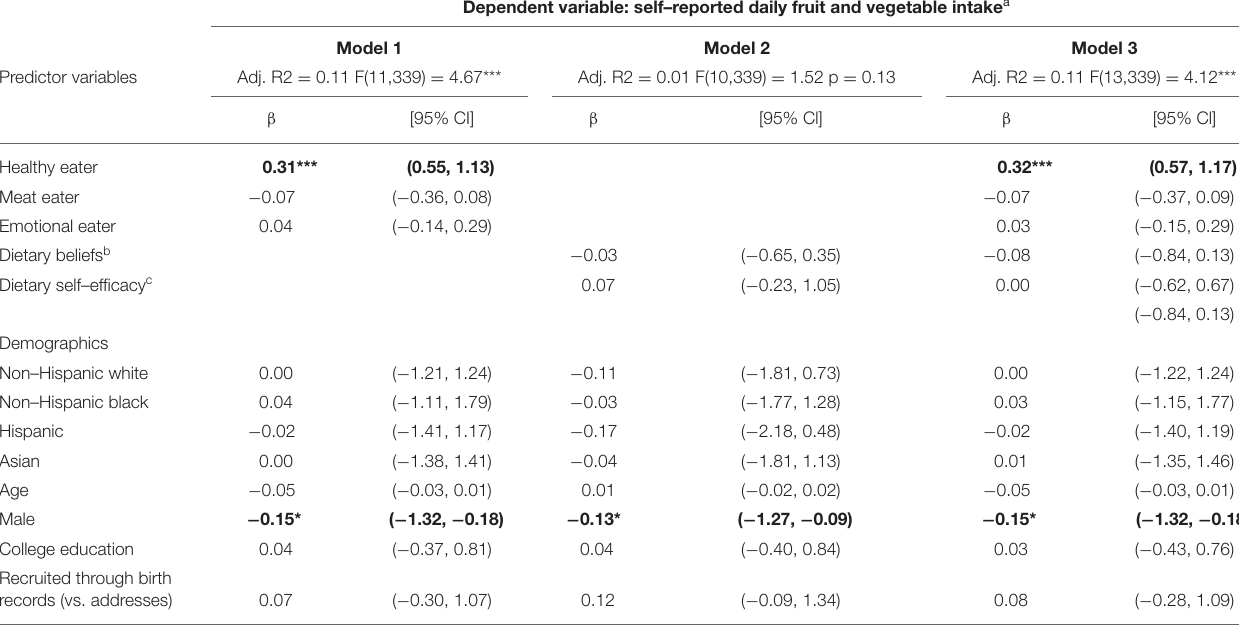
TABLE 2 | Linear regressions predicting self-reported daily fruit and vegetable intake. Dependent variable: self–reported daily fruit and vegetable intake